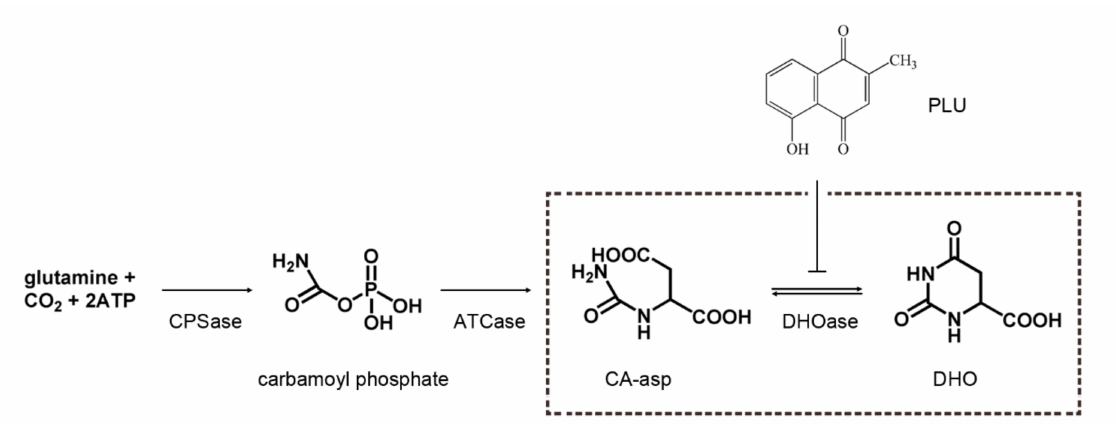
Figure 1. The gene products for the first three reactions of pyrimidine biosynthesis. DHOase catalyzes the reversible cyclization of CA-asp to DHO. In the present study, the potent anticancer drug plumbagin (PLU) was found to be a novel and non-DHO analog inhibitor of